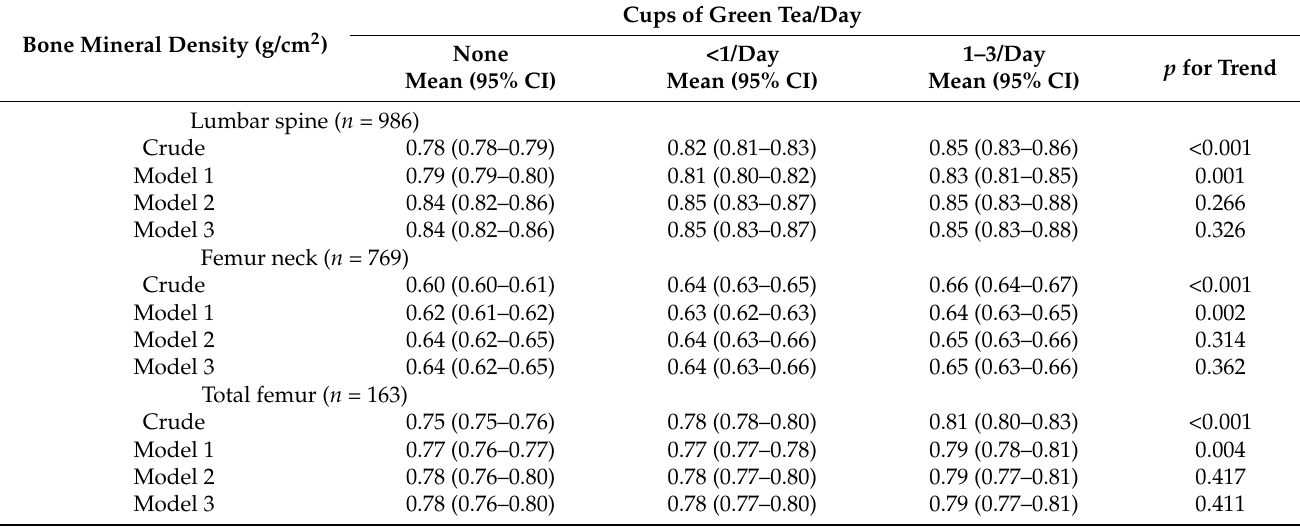
Table 3. The crude and adjusted means of bone mineral density with green tea